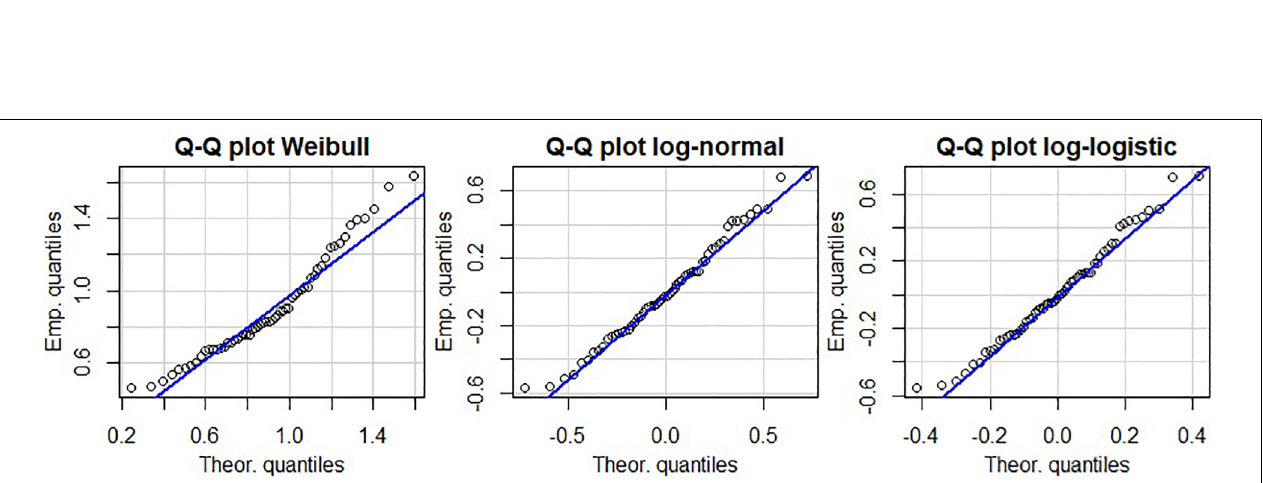
FIGURE B2 | Q–Q plots of residuals versus fitted Weibull (left) , log-logistic (middle) , and log-normal (right) distributions.